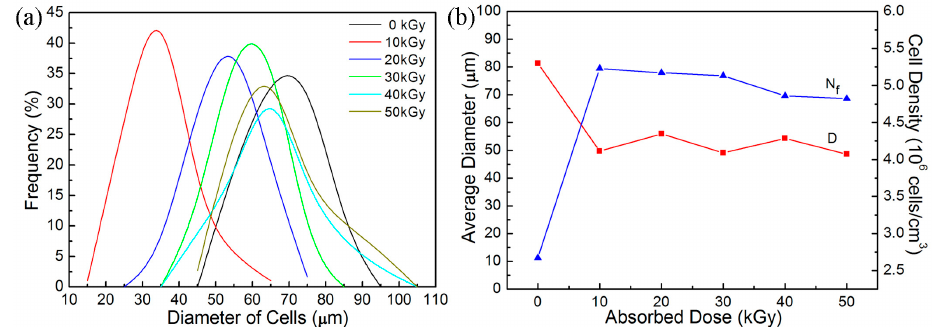
Figure 5. Effect of absorbed dose ( a ) on the cell size distribution and ( b ) on the cell diameter and cell density of the PP/TAIC foams produced at the same conditions in Figure 4.